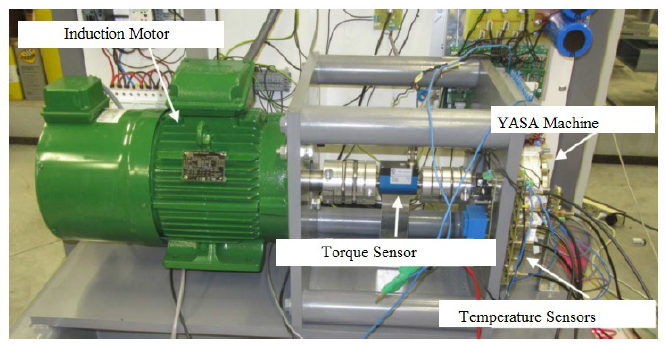
Figure 10. Experimental